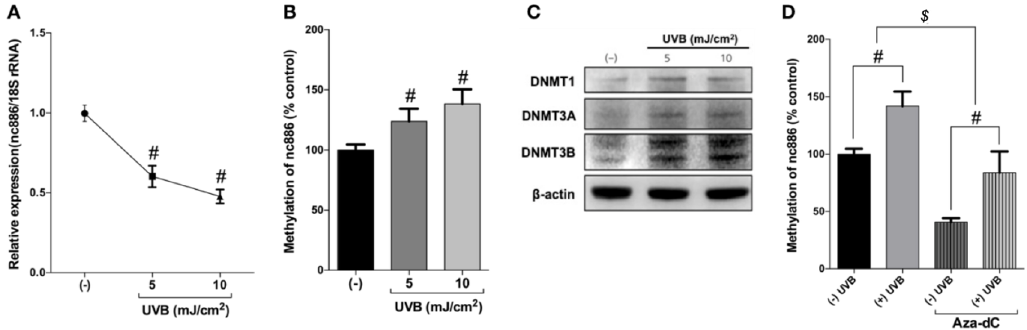
Figure 2. Analysis of the expression and methylation changes of nc886 in human keratinocytes exposed to ultraviolet light UVB. The cells were irradiated with UVB at 5 and 10 mJ / cm 2 . Total RNA and gDNA samples were collected 24 h after UVB irradiation, and protein samples were collected six hours after UVB irradiation. Samples were analyzed by ( A , B , D ) qRT-PCR, and ( C ) Western blot analysis. The nc886 mRNA level was normalized with 18S rRNA and the methylated-nc886 level was normalized with glyceraldehyde 3-phosphate dehydrogenase (GAPDH). The levels of expression were compared to the control for ( A ) nc886, illustrated in a fold change. A percentage compared to the control was used to indicate the levels for ( B , D ) methylation of nc886. # p < 0.01, compared to basal levels; $ p < 0.01, compared between ( − ) Aza-dC and ( + ) Aza-dC groups.